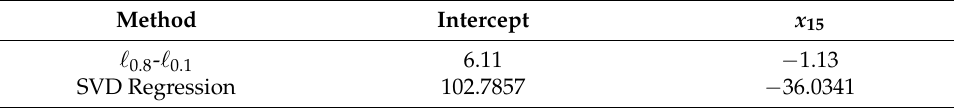
Table 5. The selected model for William’s data (real case).